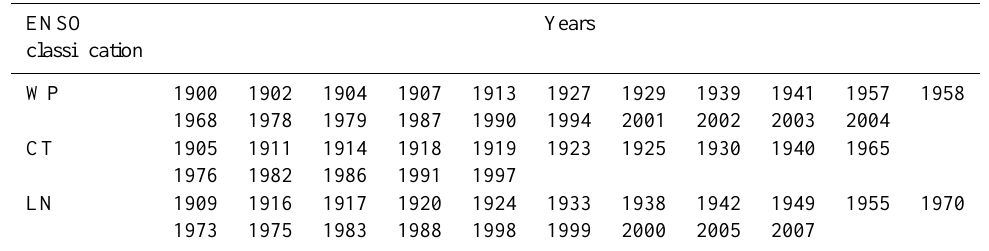
Table 1. Classification into ENSO flavors and phase based on Jan n + 1 values (see Sect. 2.2). Note the use of the Southern Hemisphere convention (Schulman, 1956), i.e., year n refers to Jan n + 1 .